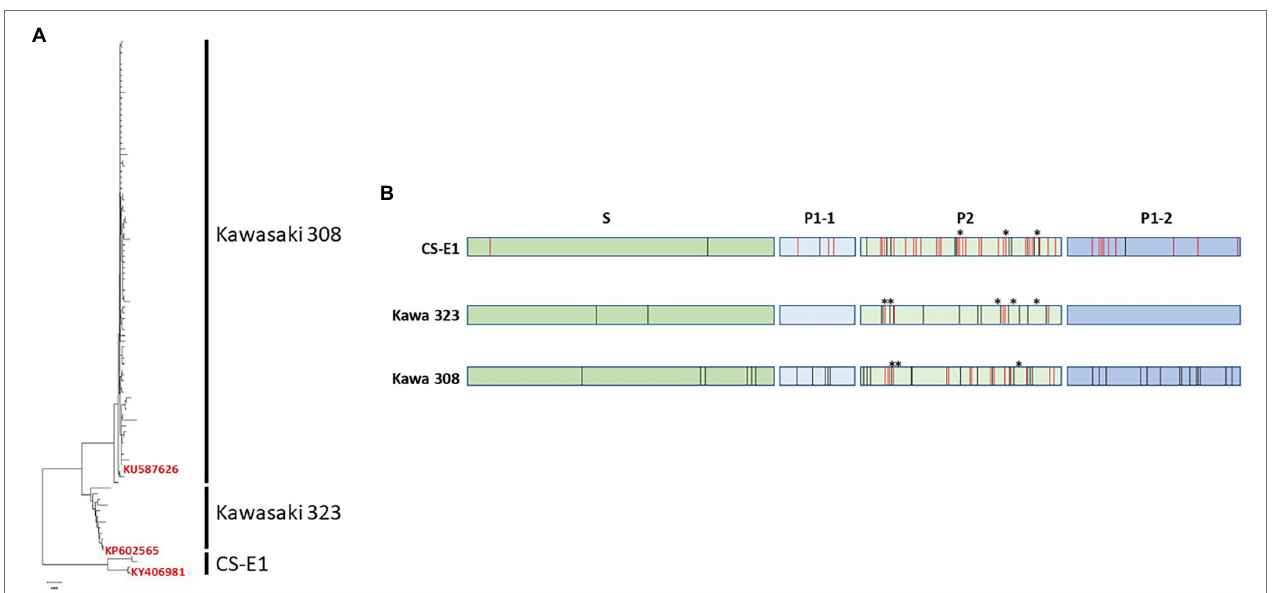
FIGURE 1 | Genetic analysis of GII.17 human norovirus (HuNoV). (A) Neighbor-joining dendrogram of the 93 unique amino acid sequences corresponding to GII.17 ORF2. Variants are indicated on the right side of the dendrograms. For each variant, one isolate was selected for VLP production. The GenBank registration number of the isolate is indicated on the tree. (B) Summary of the alignment of the 93 amino acid sequences of GII.17. The sequences were divided into the three GII.17 variants, CS-E1, Kawasaki 323, and Kawasaki 308. S, P1, and P2 domains are indicated above the graph. Variations within each variant and between variant are indicated by black and red bars, respectively. Deleted amino acid residues are indicated by